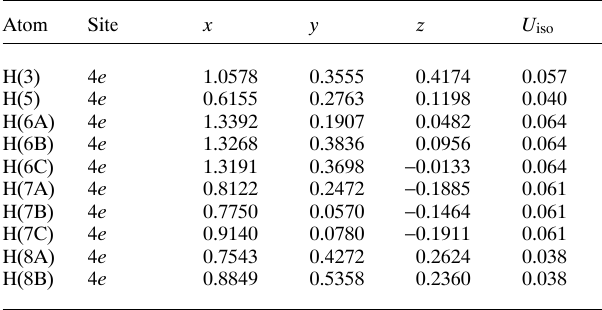
Table 2. A tomic coordin a tes a nd displ a cement p a r a meters (in Å 2 )